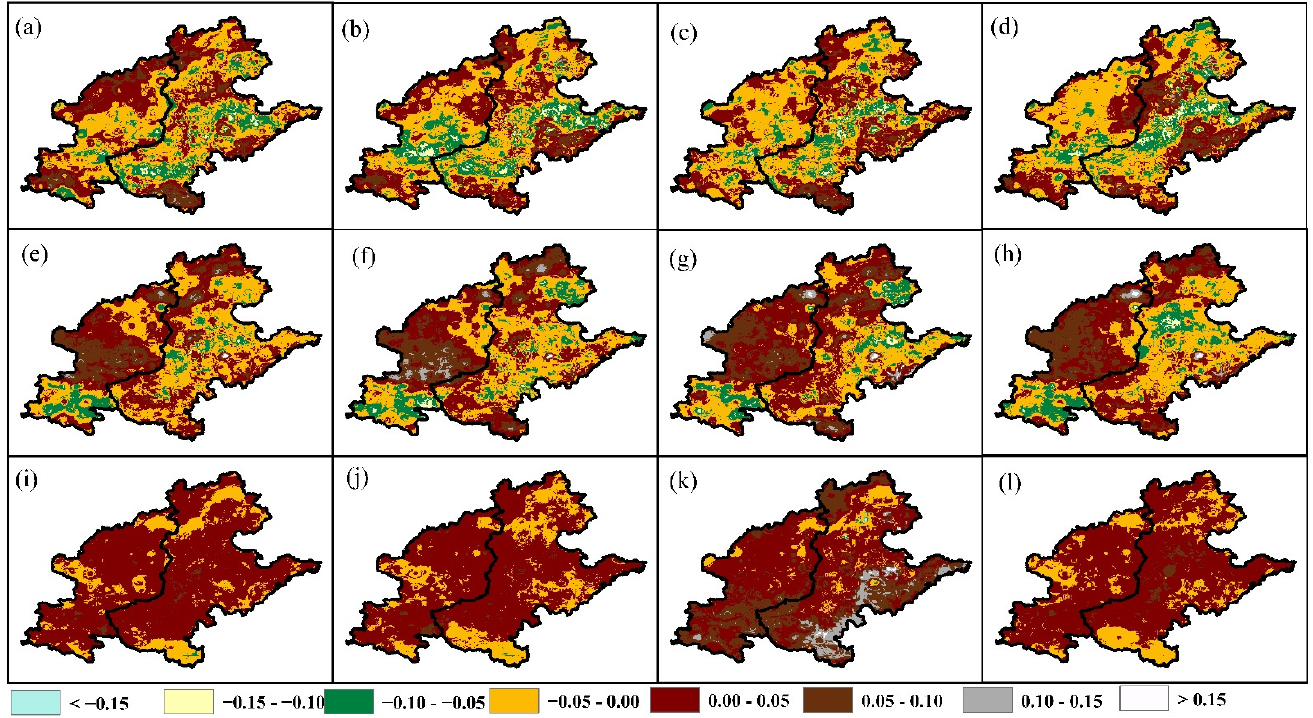
Figure 12. Spatial distributions of the frequency difference of the SPEII6 moderate drought in 2020–2039 ( a ), 2040–2059 ( b ), 2060– 2079 ( c ) and 2080–2100 ( a ) under the RCP4.5 scenario; the frequency difference of the SPEII6 severe drought in 2020–2039 ( e ), 2040–